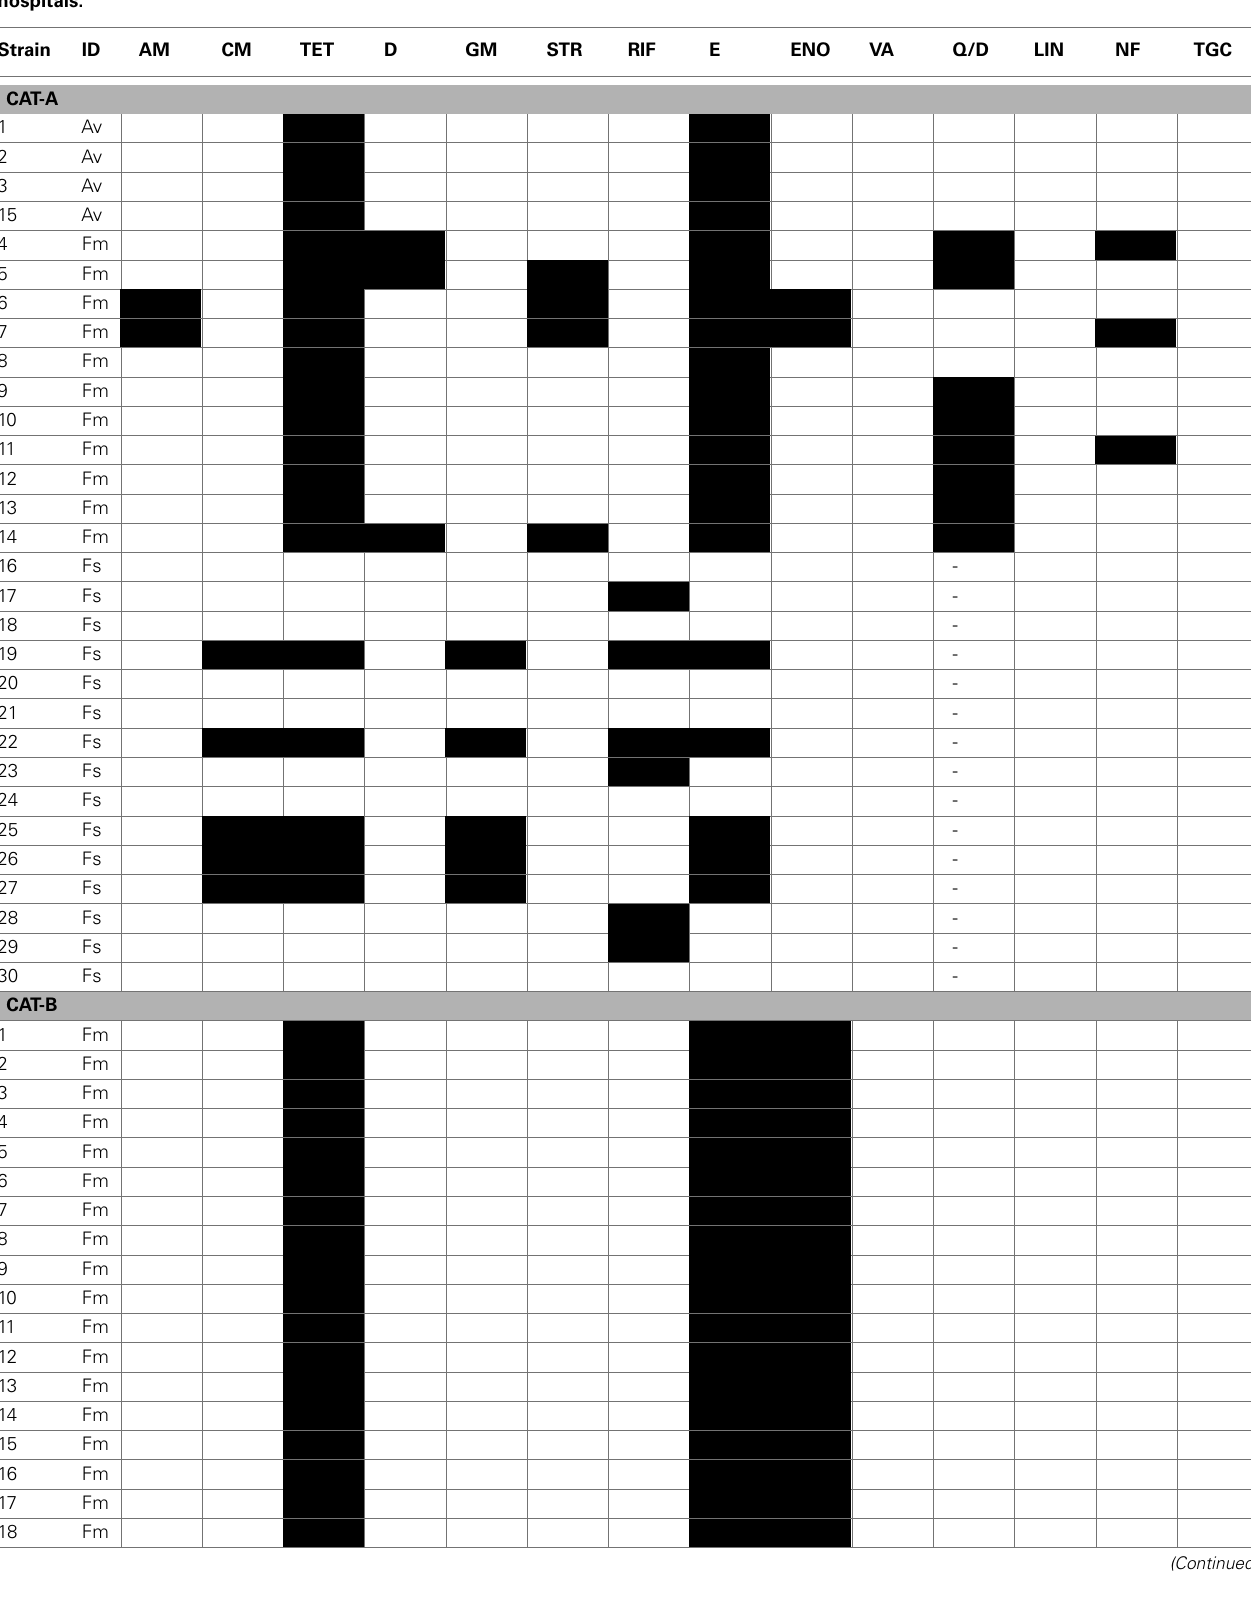
TableA2 |Antimicrobial resistance profile of enterococcal isolates from the feces of individual resident cats from small animal veterinary